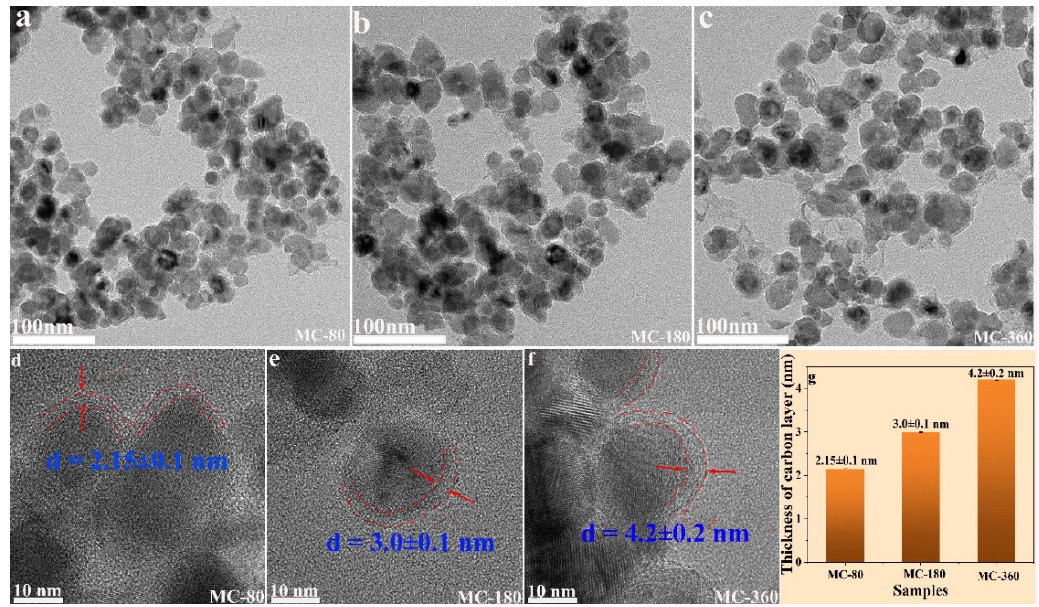
Figure 4. TEM ( a – c ) and HRTEM ( d – f ) images of samples MC-80, M-180, and MC-360. Histogram of the carbon thickness of samples MC-80, M-180, and MC-360 ( g ).